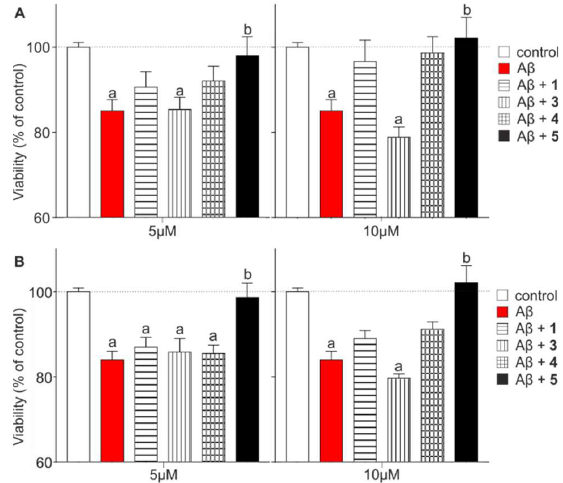
Figure 6. Cell viability readouts based on impedance analysis after treatments at different time points: ( A ) 24 h ( B ) 48 h. Viability of the treated cells was compared to the untreated SHSY-5Y neuroblastoma cells (control group). A β oligomer was used in 10 µ M concentration in each case: alone (red column) and in the presence of 5 and 10 µ M compound 1 , 3 – 5 , respectively. (Statistics: Two-way